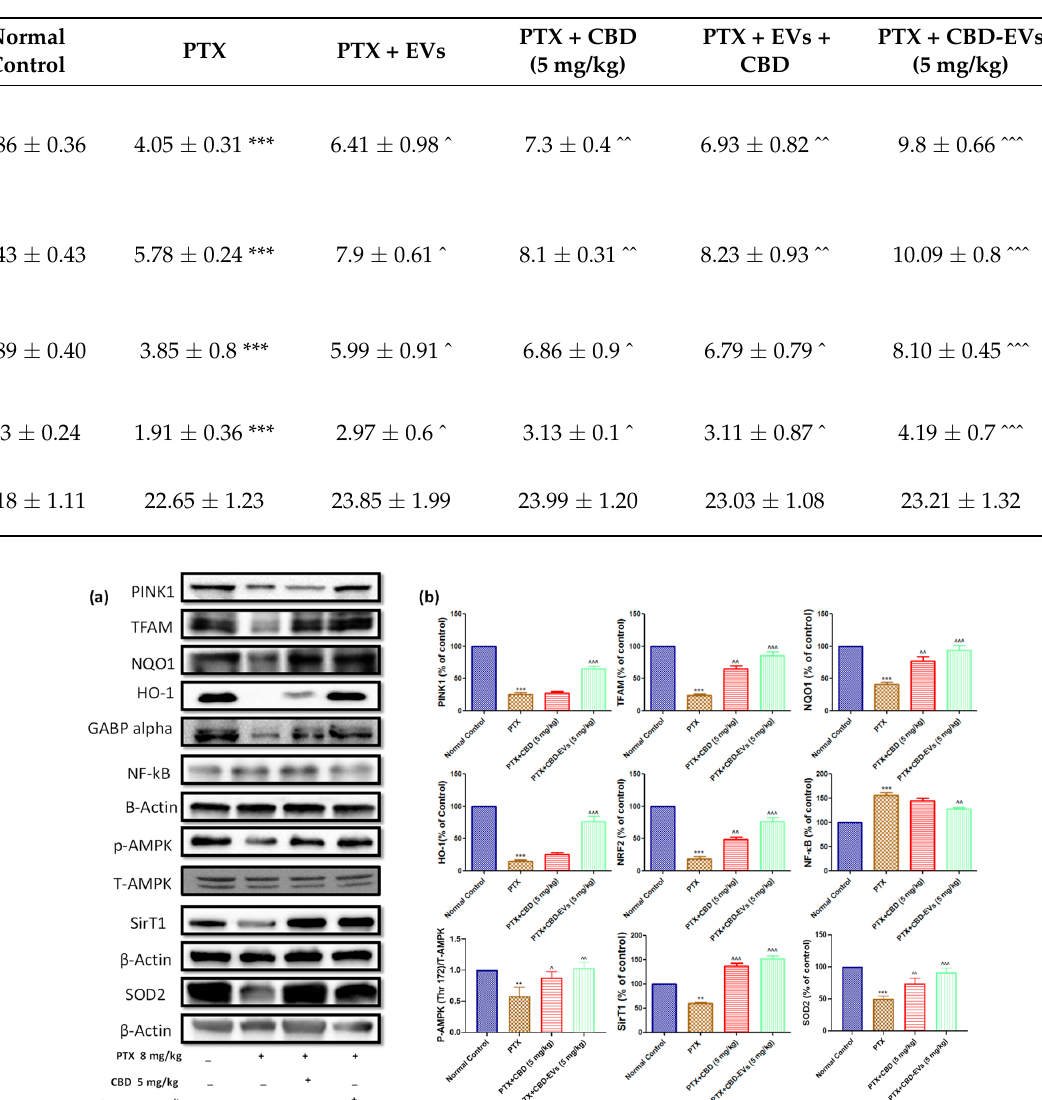
Table 1. Effect of EVs, CBD, and CBD-EVs on PTX-induced neurobehavioral changes: The values are expressed as mean standard error of the mean (n = 6). Normal Control: untreated age-matched mice, PTX: mice received (8 mg/kg/day) on alternate days for four injections cumulatively, PTX + EVs: Mice were given extracellular vesicles protein (10 mg/kg, i.p.) twice a week for six weeks after the last dose of PTX. PTX + CBD (5 mg/kg): 5 mg/kg CBD (i.p.) injected twice a week for six weeks after the last PTX injection, PTX + CBD + EVs: 5 mg/kg of CBD and hUCMSCs-derived EVs (i.p.) injected twice a week for six weeks after the last dose of PTX injection. PTX + CBD-EVs: 5 mg/kg of CBD loaded in hUCMSCs-derived EVs (i.p.) injected twice a week for six weeks after the last dose of PTX injection. *** p < 0.001 vs. Normal control and ˆ p < 0.05, ˆˆ p < 0.01 and ˆˆˆ p < 0.001 vs. PTX.